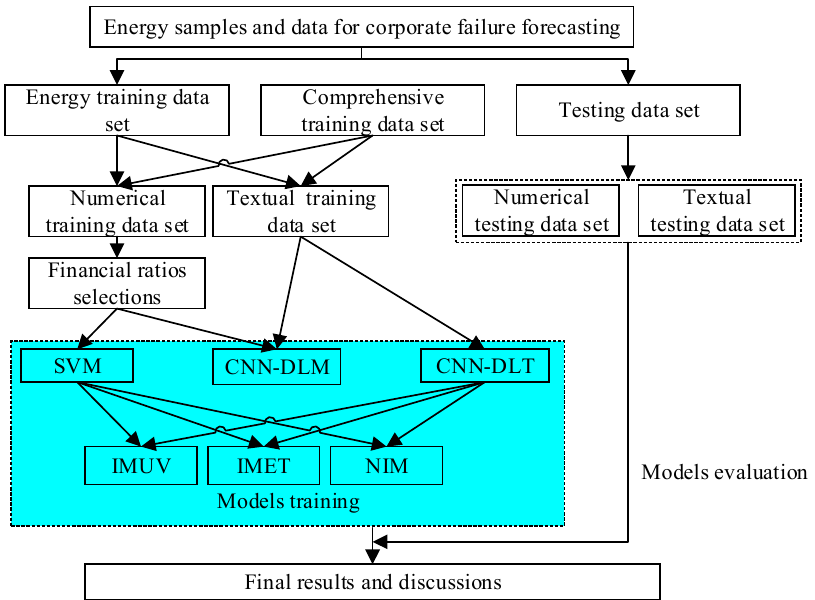
Figure 3. The framework of the empirical experiment. SVM: support vector machine; CNN-DLT: convolutional neural network oriented deep learning (CNN-DL) trained using textual data; CNN-DLM: CNN-DL trained using textual data and numerical data; IMUV: unanimous voting method; IMET: Dempster–Shafer evidence theory.